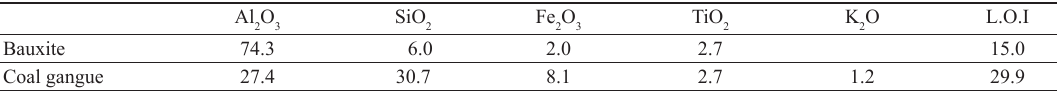
Table 1. Chemical compositions of the raw materials (wt%).